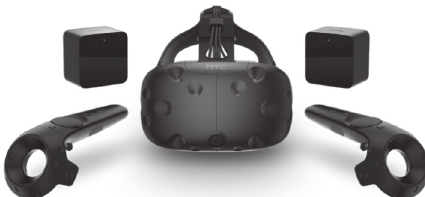
Figure 5: HTC VIVE wearable